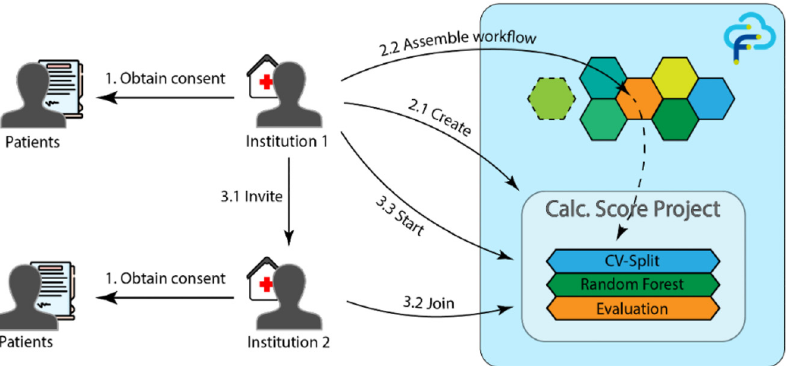
Figure 1: Two institutions used the FeatureCloud platform and institution 1 has been the FL project leader (Authors).